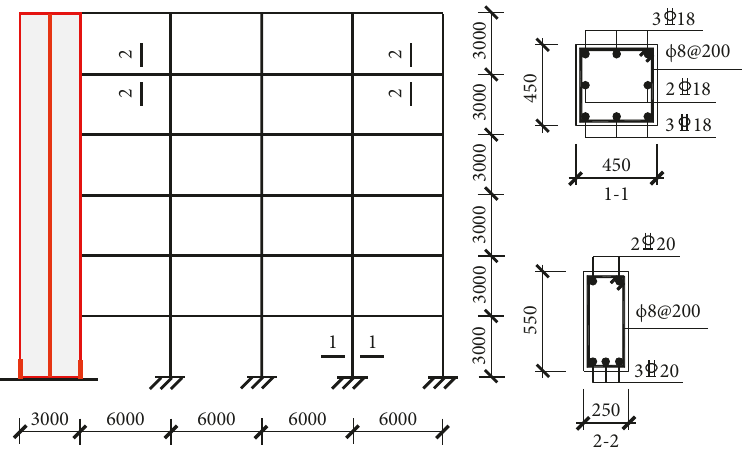
Figure 7: Details of the analyzed FSCW structure (length unit: